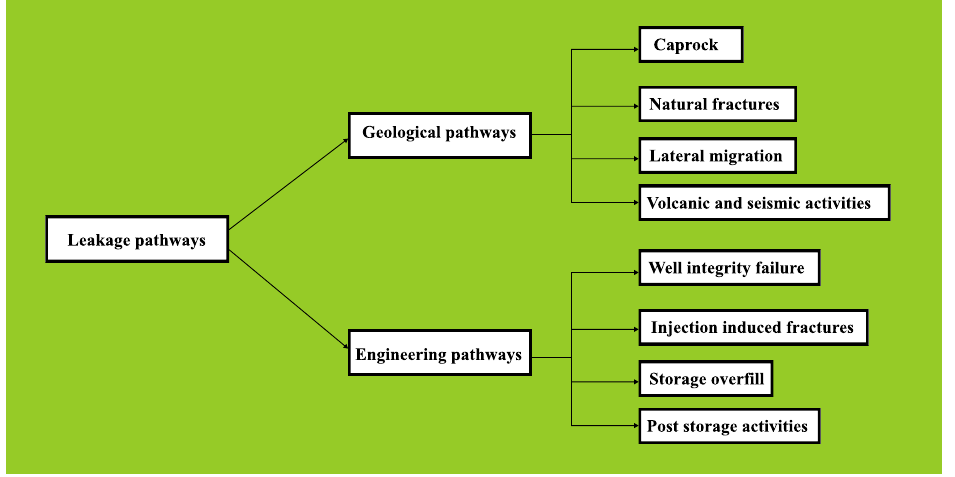
Figure 7. CO 2 leakage